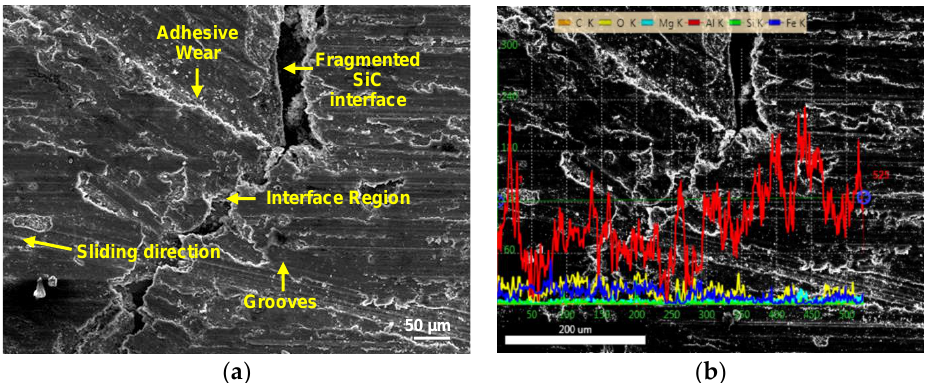
Figure 9. Worn surface morphology at the AA6063/SiC interface: ( a ) SEM micrograph; ( b ) line scanning elemental analysis.